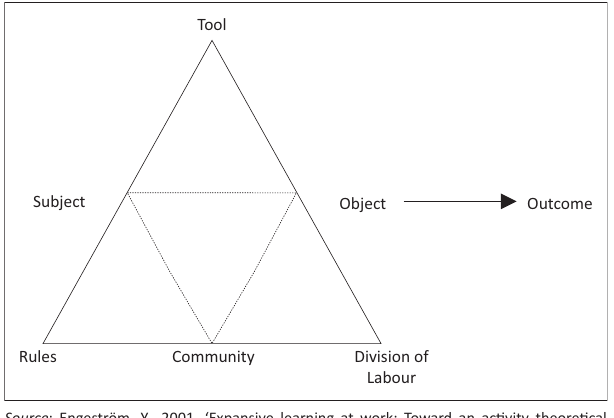
FIGURE 1: Engeström’s expended activity theory